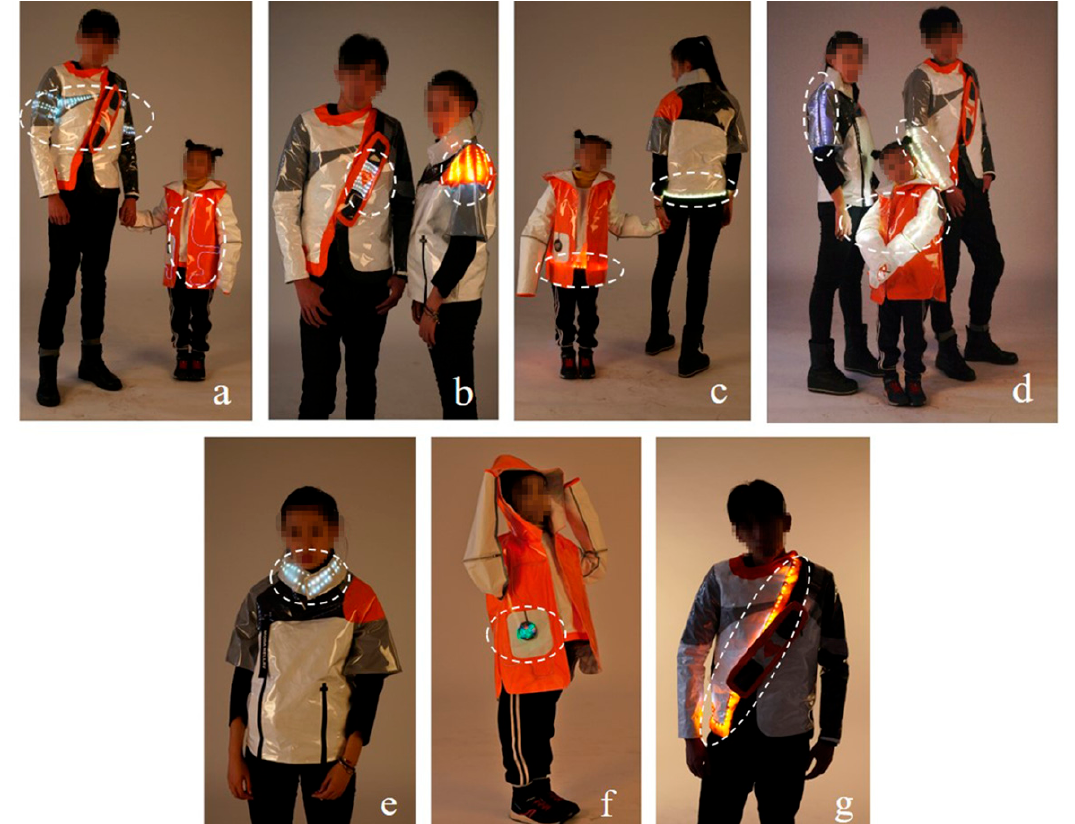
Figure 5. Prototypes. ( a ) The interaction between father’s and child’s clothing; ( b ) Interaction between a husband’s and wife’s clothing; ( c ) Interaction between mother’s and child’s clothing; The interaction between father’s and children’s clothing; ( d ) Interaction between father’s, mother’s, and children’s clothing; ( e ) Self-reaction of mother’s clothing; ( f ) Self-reaction of child ‘s clothing; ( g ) Self-reaction of father’s clothing.